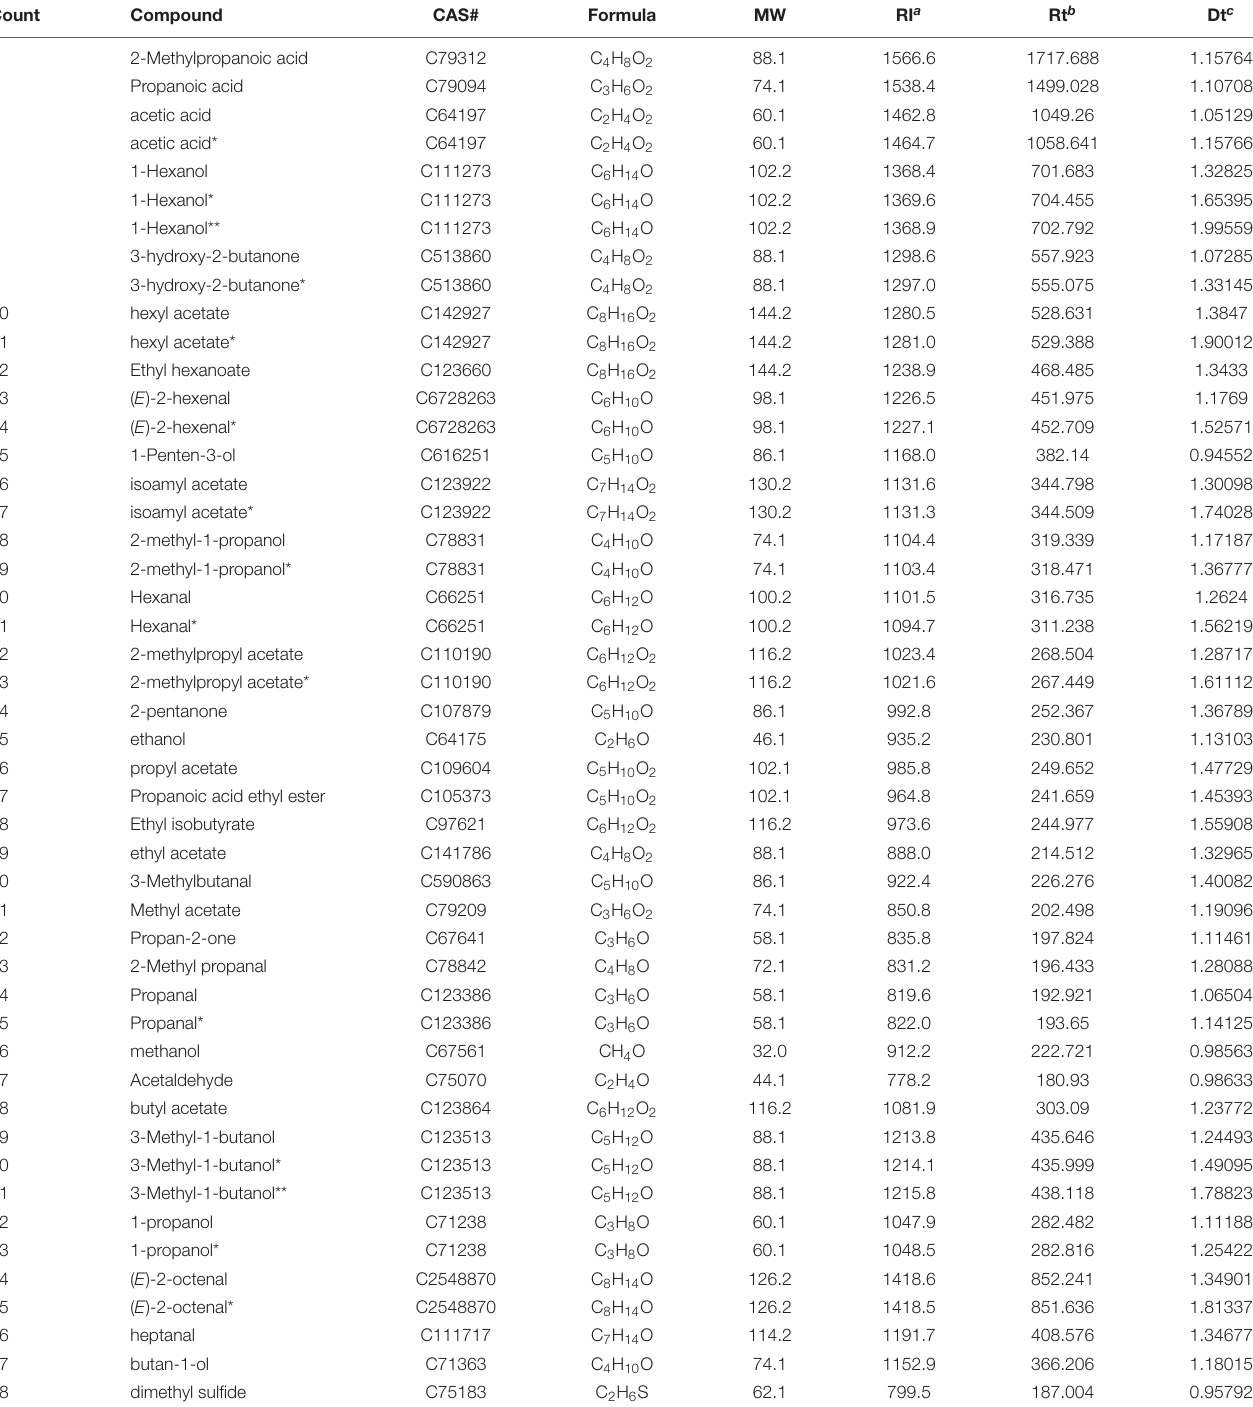
TABLE 1 | Compositions of the volatile substances determined by gas chromatography-ion mobility spectrometry (GC-IMS)